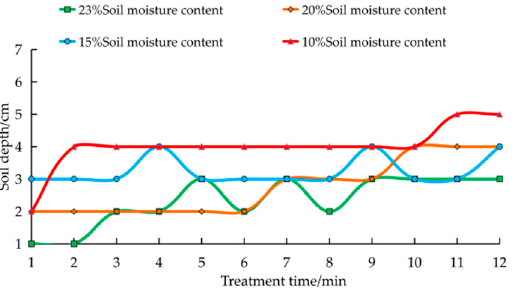
Figure 38. The location of the average maximum temperature ⎯ T n max of the loess layer.